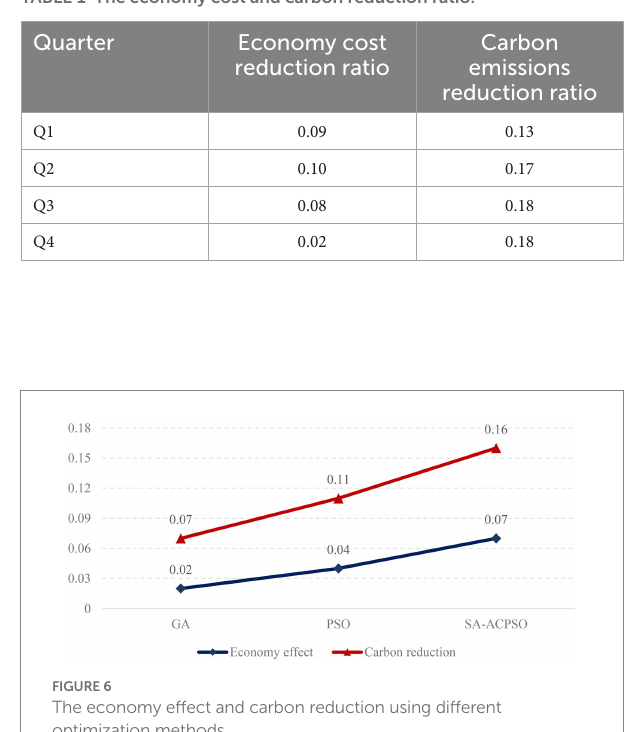
TABLE 1 The economy cost and carbon reduction ratio.